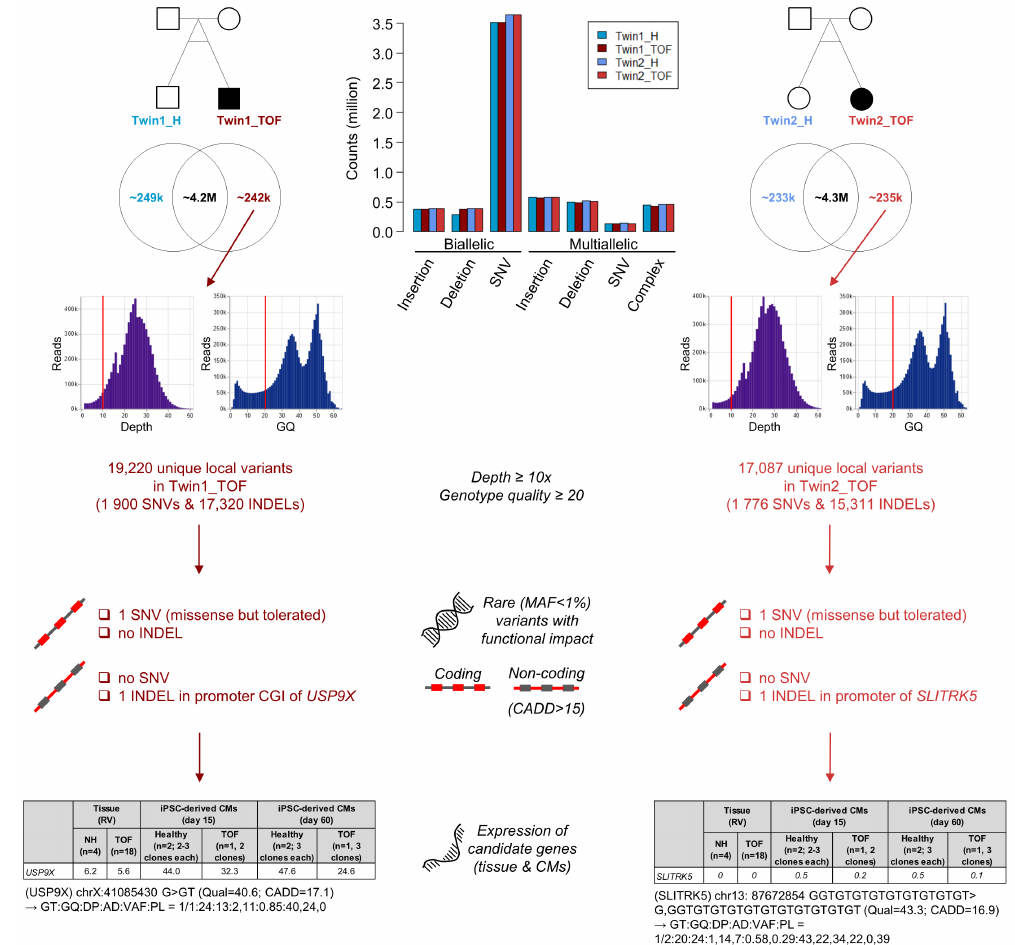
Figure 1. Filtering of local variations and candidate genes identified in a ff ected Tetralogy of Fallot (TOF) twins using whole genome sequencing. Variant positions are based human reference genome (GRCh38.p13 / hg38). AD, allelic depth; CADD, combined annotation dependent depletion; CMs, cardiomyocytes; DP, read depth; GT, genotype; GQ, genotype quality; H, healthy; INDEL, insertion and deletion; MAF, minor allele frequency; NH, normal heart; PL = Phred-scaled genotype likelihoods; Qual, base quality (Phred score); RV, right ventricle; SNV, single nucleotide variations; TOF, Tetralogy of Fallot; VAF, variant allele